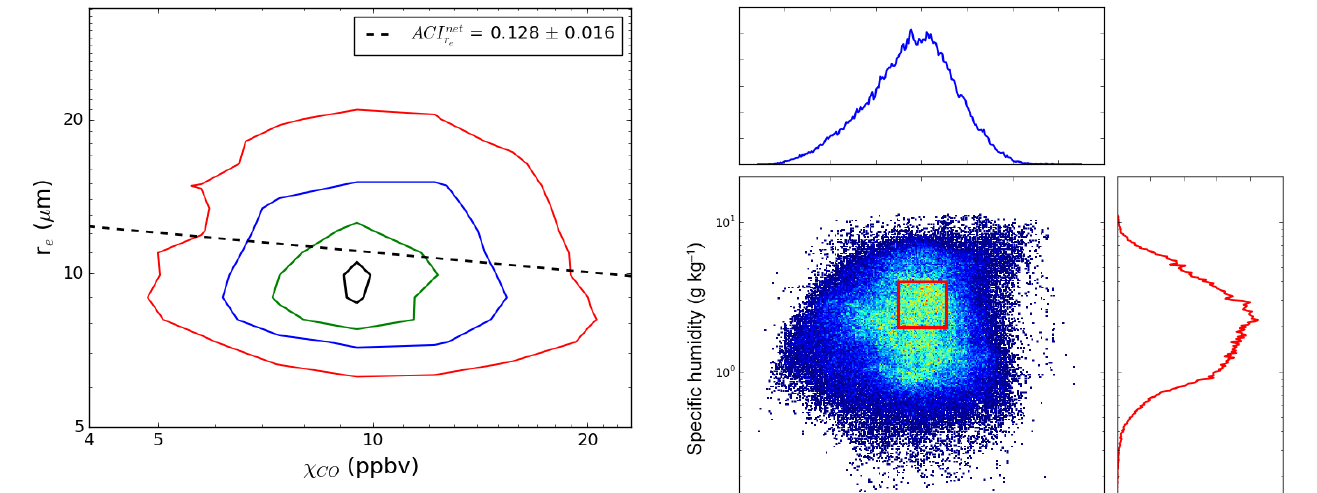
Figure 3. Calculation of the ACI net r parameter from a probability e distribution of values in the effective radius and CO tracer concen- tration for liquid clouds with cloud top altitudes between 1000m and 2000m, and cloud top temperatures between − 12 and 6 ◦ C. Figure 4. A 2-D histogram of the specific humidity and the LTS re- The color scale indicates higher density of values in linear inter- trieved by ECMWF reanalysis from 2008 to 2010. The red rectangle number indicates the negative slope of the linear vals. The ACI net r corresponds to the range where there is a maximum of measure- e fit (dashed line). ments within a bin corresponding to 15% of the total range length of the corresponding parameter. Table 2. Summary of the different ranges of the logarithm of the specific humidity and the LTS over the region of interest, detailing the method used to determine the final range of parameters consid- ered. The (cid:49) defines the difference between the maximum and the minimum of the total range. The considered range is chosen to keep the maximum number of measurements within a fixed interval of 15% of the range, corresponding to the red square on Fig.